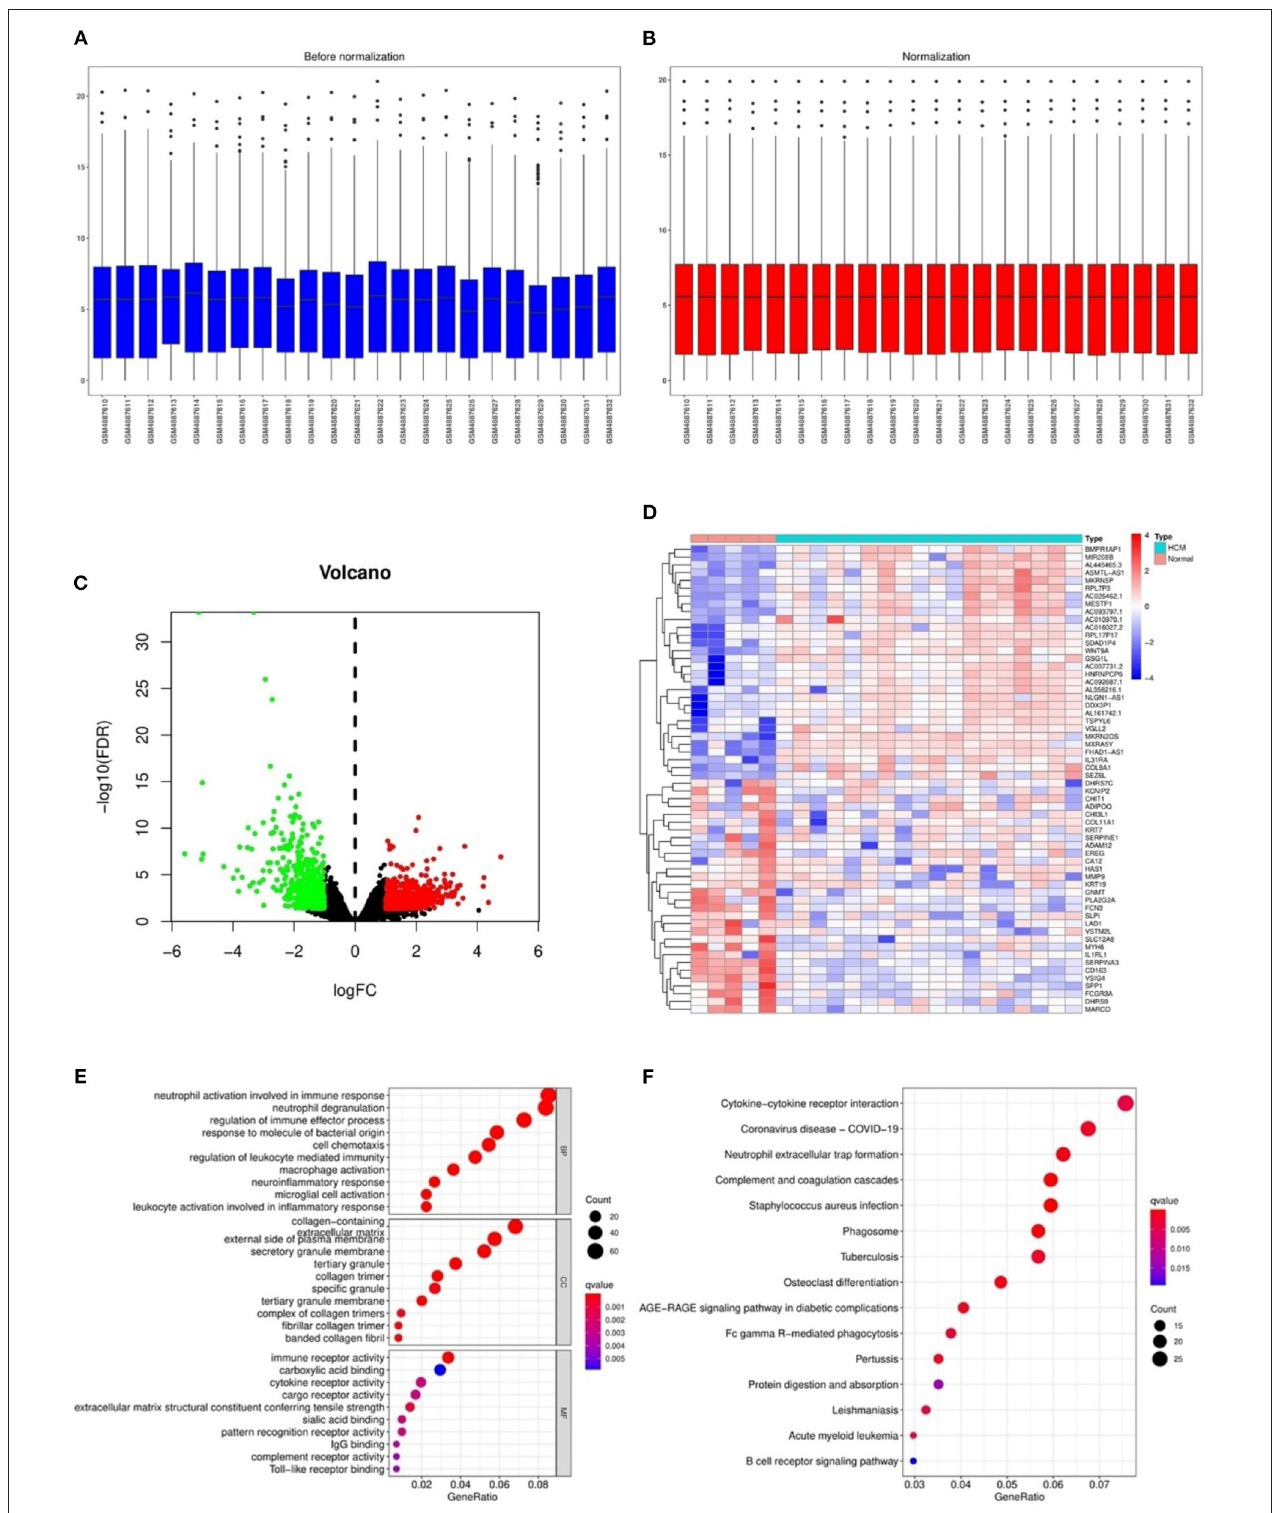
FIGURE 2 | The differentially expressed genes in GSE160997 and the Gene Ontology annotation and Kyoto Encyclopedia of Genes and Genomes pathway enrichment analysis. (A) The boxplot of GSE160997 before normalization. (B) The boxplot of GSE160997 after normalization. (C) The Volcano plot of 1,079 DEGs, with 618 significantly upregulated (red) and 461 significantly downregulated (green). (D) The heatmap of top 30 DEGs. (E) The gene ontology (GO) annotation of DEGs. (F) The Kyoto Encyclopedia of Genes and Genomes (KEGG) enrichment analysis of DEGs.